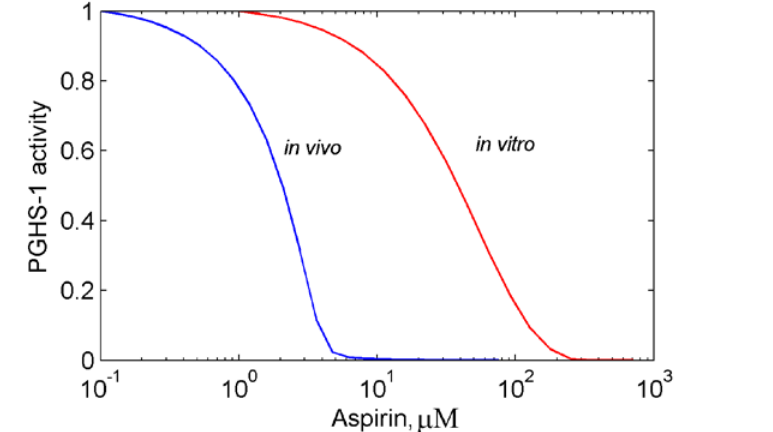
Figure 3. Dose dependence for aspirin calculated for purified PGHS-1 (red line) and platelet PGHS-1 (blue line). The enzyme activity (oxygen consumption (red line) and production of PGH (blue line)) is given in relative 2